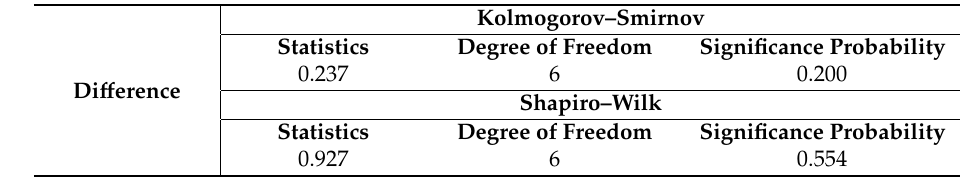
Table 4. Normality test of di ff erence